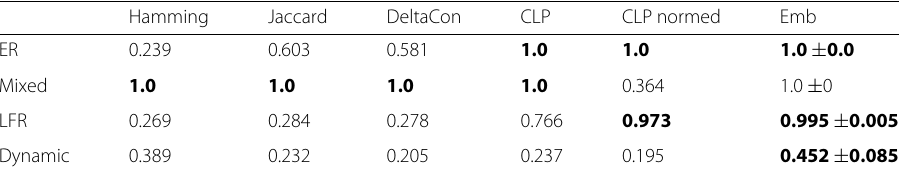
Clustering results for synthetic datasets